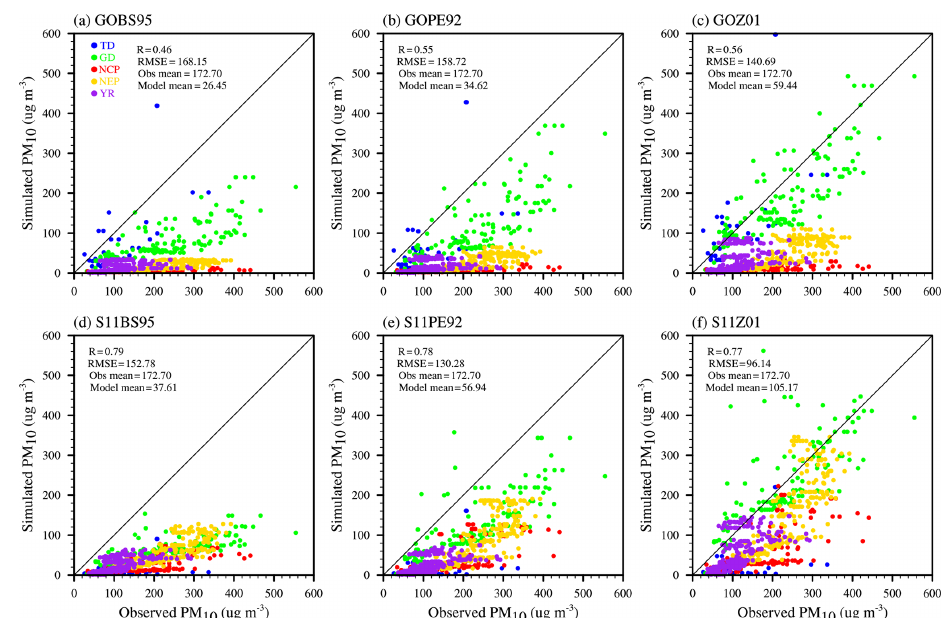
Figure 8. Simulated PM 10 versus observed PM 10 for six experiments (a) GOBS95, (b) GOPE92, (c) GOZ01, (d) S11BS95, (e) S11PE92, and (f) S11Z01 over the 7d simulation period 1–7 May 2017. “Obs mean” is mean PM 10 over 1–7 May from observation; “Model mean” is mean PM 10 over 1–7 May from simulation; “ R ” is the correlation coefficient between model and observations; “RMSE” is the root mean square error. Different color dots represent different regions as shown in Fig. 6.